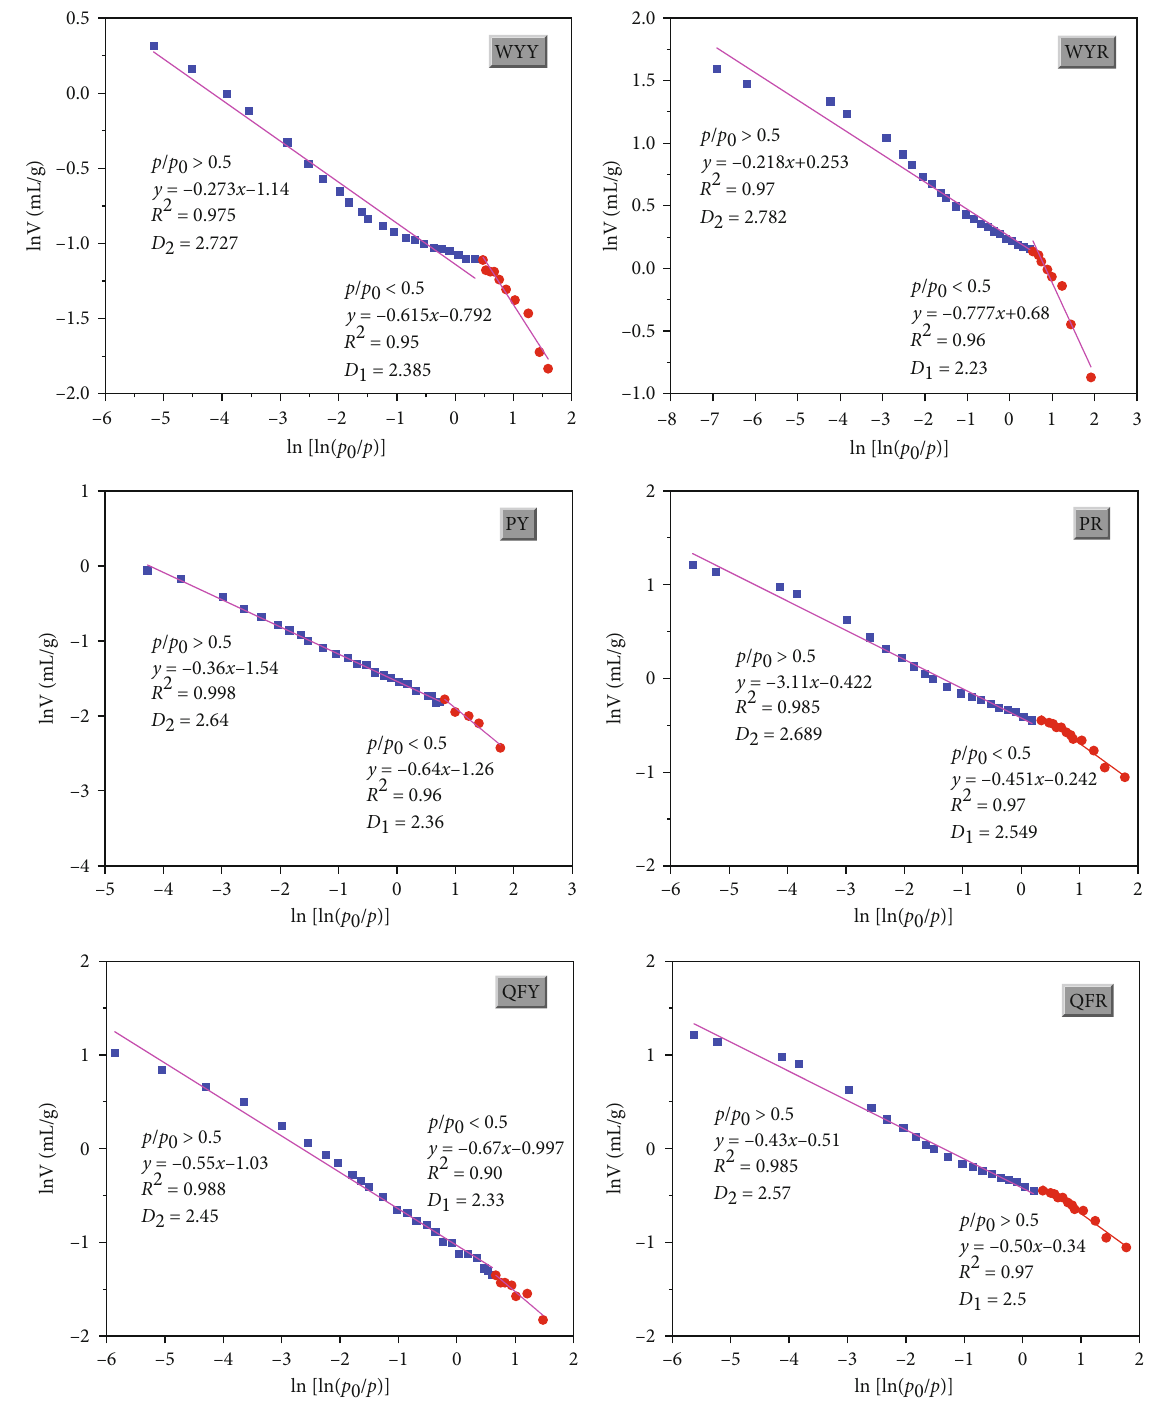
Figure 5: Fractal dimension of coal